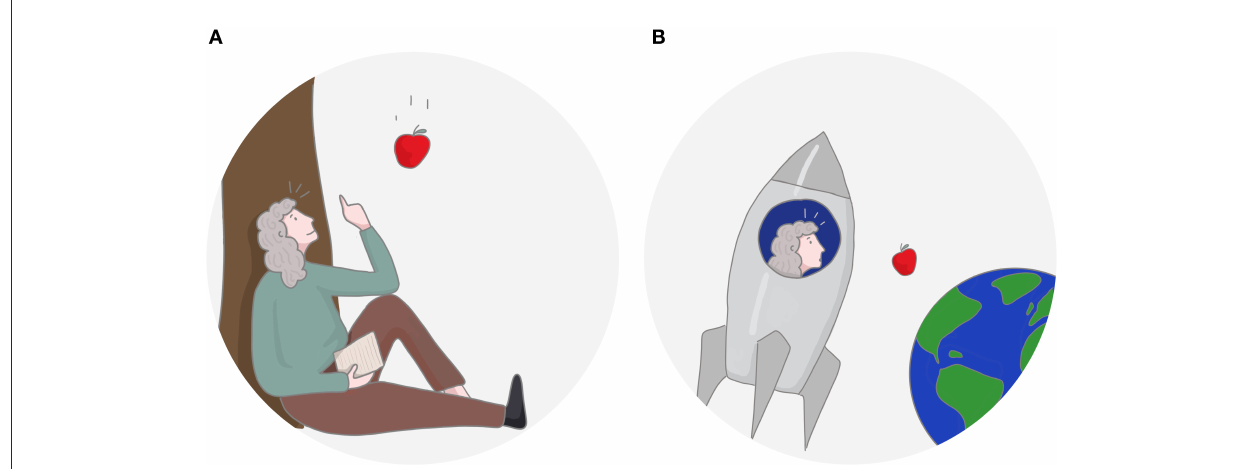
FIGURE1 (A) Modeling classically aims at an objective description, from which the modeler should be absent. (B) However, the choice of the model may depend on the modeler and their experiences; Newton probably would not have proposed the same model of gravity, had he grown up in a space shuttle. We argue that helping a modeler in modeling may require putting the modeler back into the